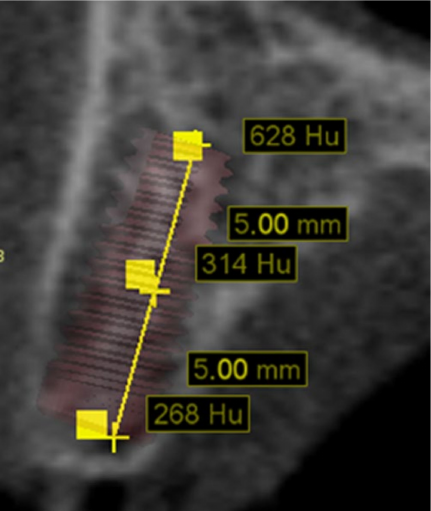
Figure 1. The bone density at the implantation site was determined as the mean of the grey values (Hu) of trabecular bone from cervical, body and apical